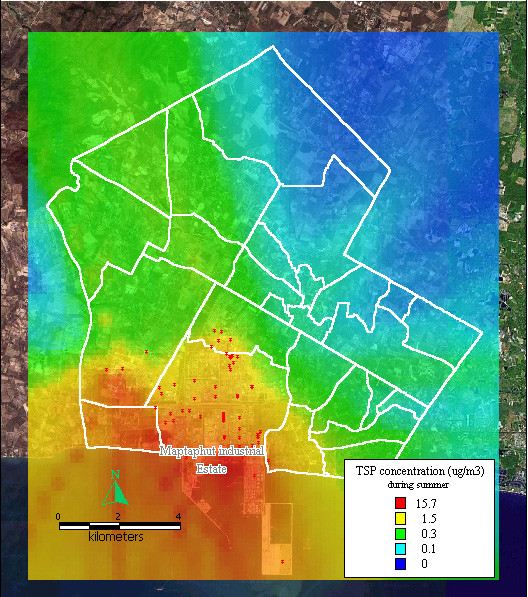
Dispersion of TSP during summer. Red dots indicate the stacks that released total suspended particle.